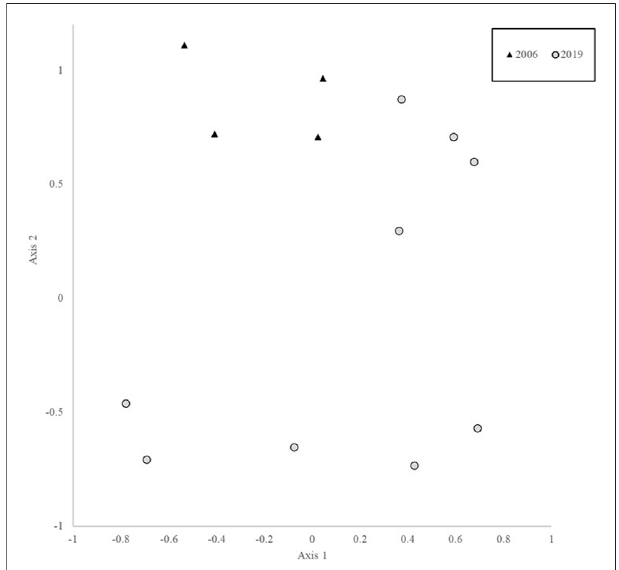
FIGURE 2 | NMS ordination of point count transect data at Binyo (2006 and 2019). MRPP value T = 2.9, A = 0.5, and p =